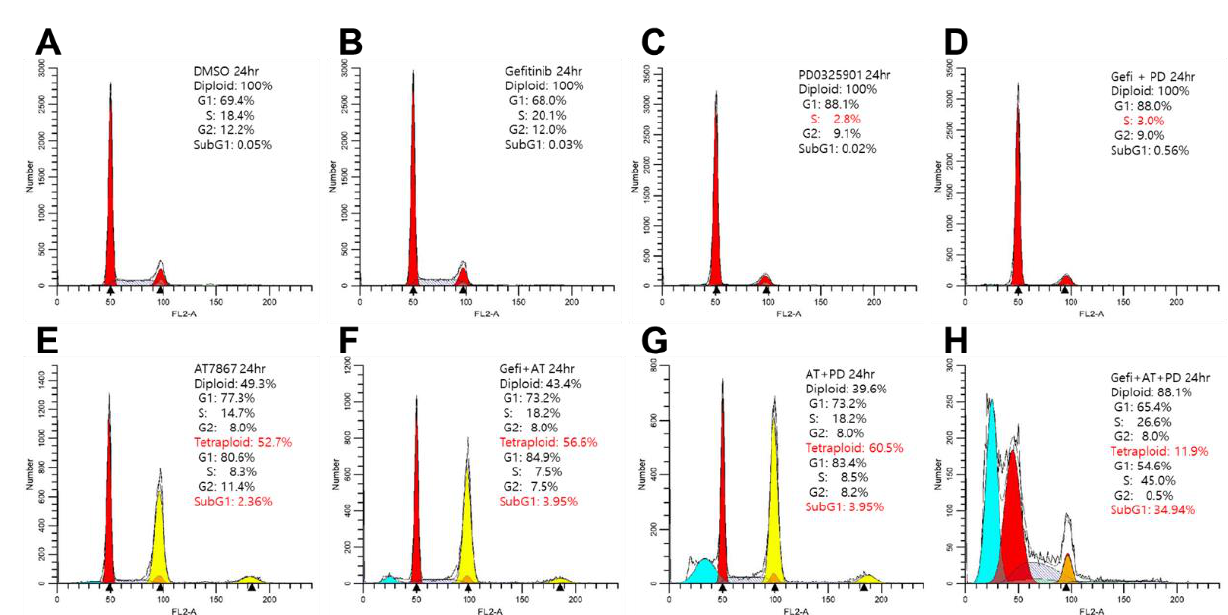
Figure 7. Cell cycle analysis of MDA-MB-231 cells treated with a triple combination of gefitinib and AT7867 and PD-0326901( A – H ). Representative histograms of cell cycle analysis in MDA-MB-231 cells in the presence of each drug or combinations of drugs as indicated. Abbreviations: AT, AT7867; Gefi, gefitinib; and PD-0325901.